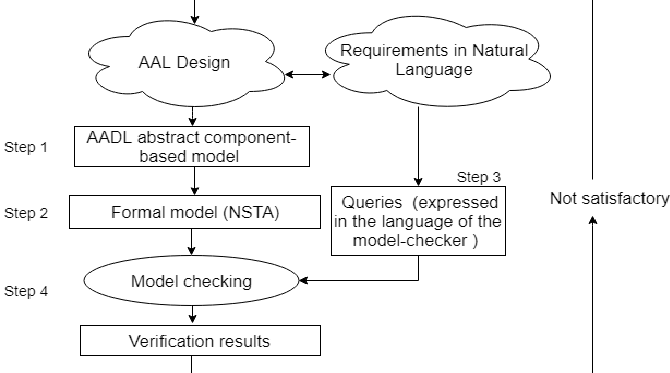
Figure 1. Methodology overview. Ambient Assisted Living (AAL), Architecture Analysis and Design language (AADL), stochastic timed automaton (STA), network of interacting STA